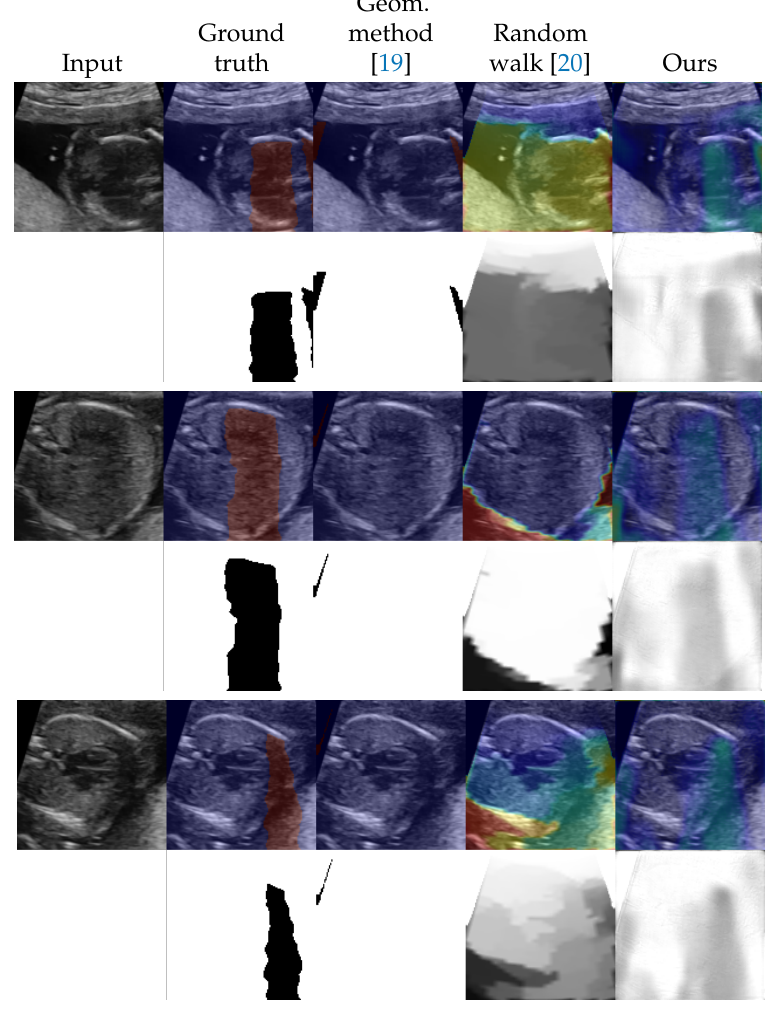
Figure A2. Additional examples of shadow detection results for the methods that do not use labels. The lower side of each example shows detection results, and the upper side shows them overlayed to the input image. For overlayed images, blue corresponds to low intensities and red corresponds to high